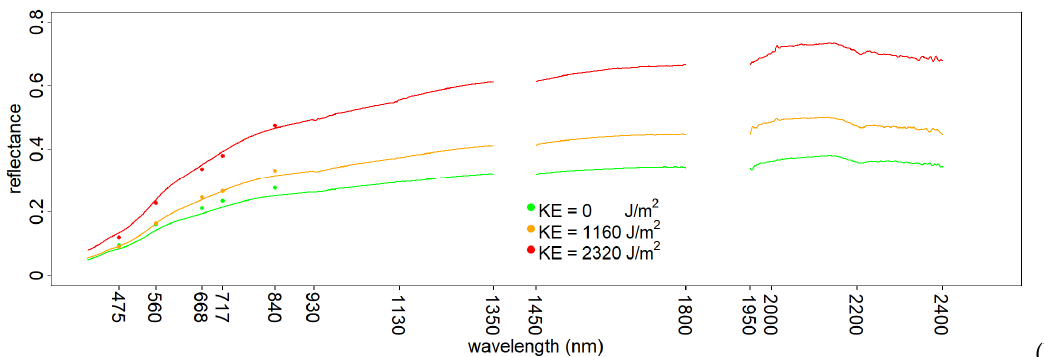
Figure 5. ( a ) Example of the evolution of the multispectral pixel density histograms, for two spectral bands drawn as an example (blue and nir, respectively colored in blue and grey), from a single soilbox across two different amounts of cumulated rainfall kinetic energy (0 and 5500 J/m 2 ). The iqr is visualized as the span distance between the 1st and 3rd quantile of each histogram; ( b ) example of the evolution of mean multispectral reflectance values (points) and corresponding hyperspecral reflectance samples (lines) at the same soilbox location, for three levels of KE (0, 1160 and 2320 J/m 2 ).